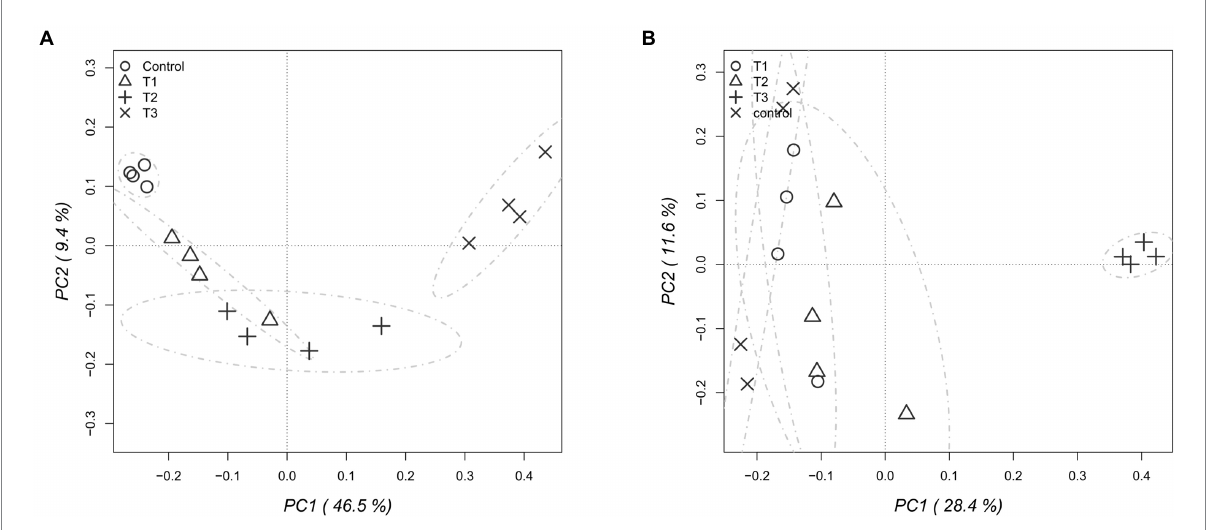
FIGURE 4 Principal component analysis (PCA) performed to assess the unconstrained grouping of the total bacterial (A) and fungal (B) OTUs, showing the relative abundance for each dose of